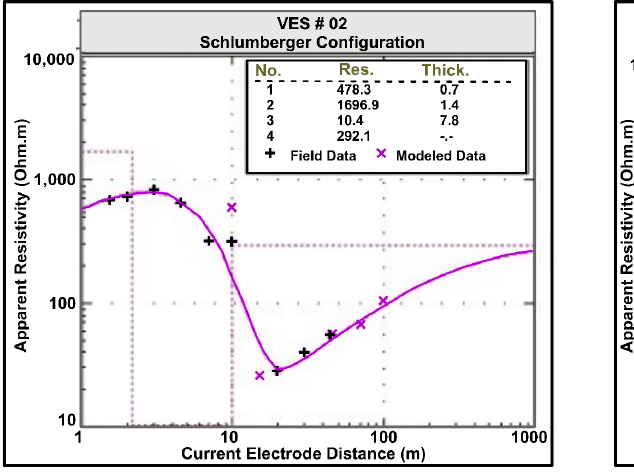
Figure 12. Apparent resistivity contour maps: ( a ) AB/2 = 1 m and ( b ) AB/2 = 30 m.